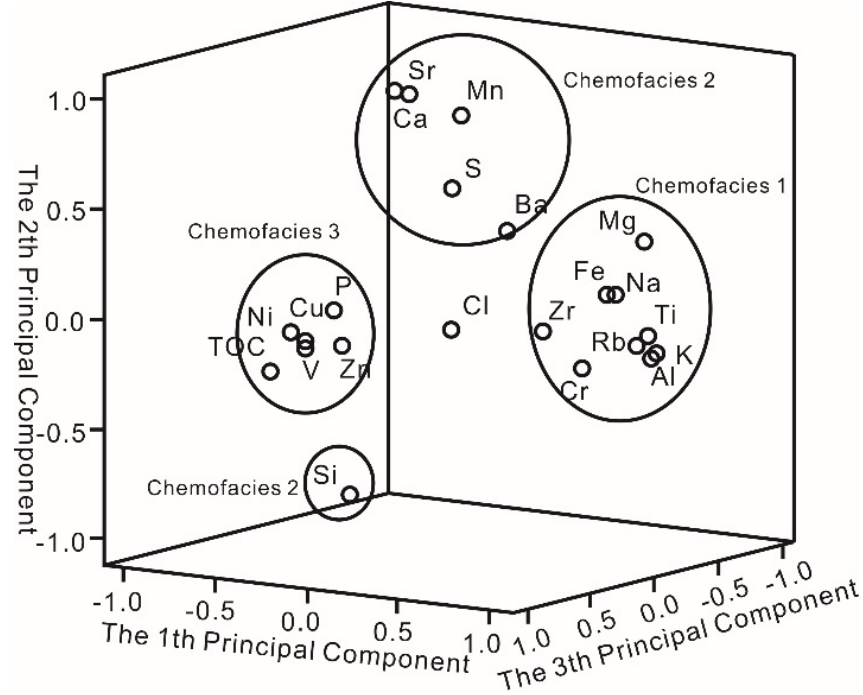
Figure 2. The spatial distribution of principal component loading of 22 elements.